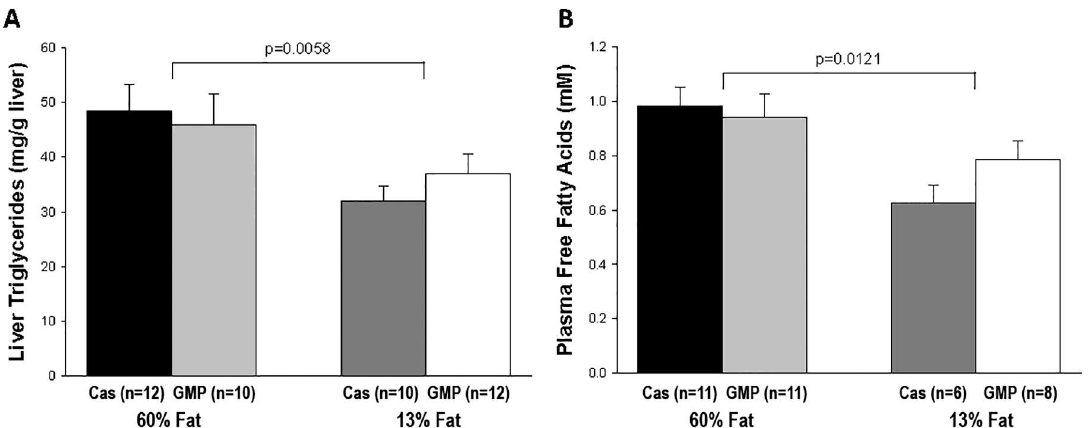
Fig 5. Concentrations of liver triglycerides and plasma free fatty acids. Concentrations of liver triglycerides (A) and plasma free fatty acids (B) in female mice fed 60%-fat casein, 60%-fat GMP, 13%-fat casein, and 13%-fat GMP diets. Values are means ± SE; nos. in parenthesesindicate sample size. Concentrationof liver triglycerides showed a significant fat effect where mice fed the high-fat diets had significantly greater liver triglycerides than mice fed the control diets (p = 0.0058). Mice fed the high-fat diets had significantly greater plasma free fatty acids than mice fed the control diets (p = 0.0121).